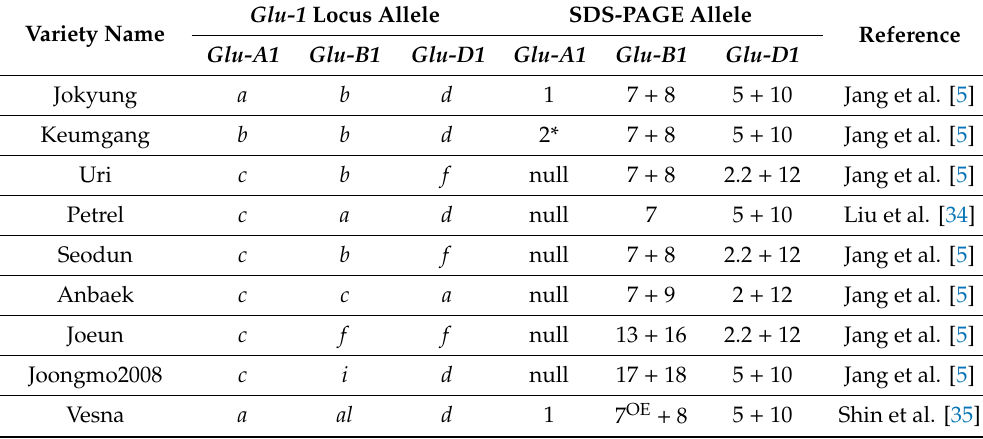
Table 1. High-molecular-weight glutenin subunit (HMW-GS) composition used as the standard varieties in this